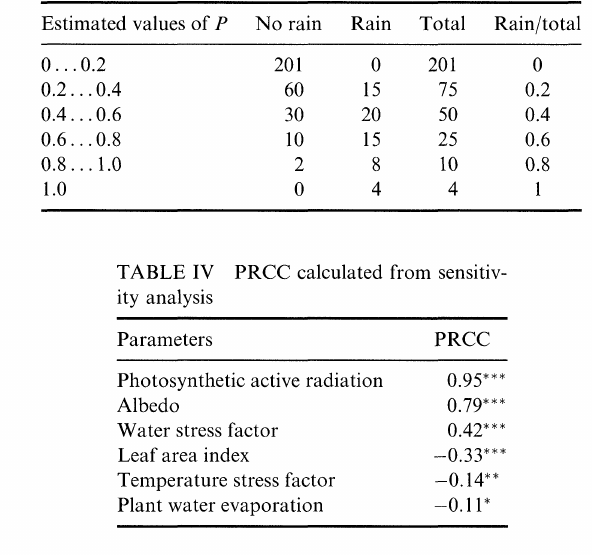
TABLE IV PRCC calculated from sensitiv- ity